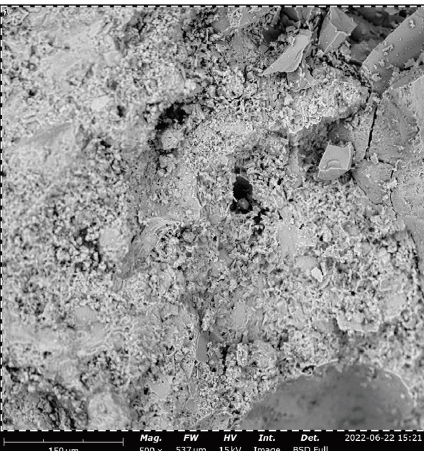
Figure 23: SEM for the control sample.